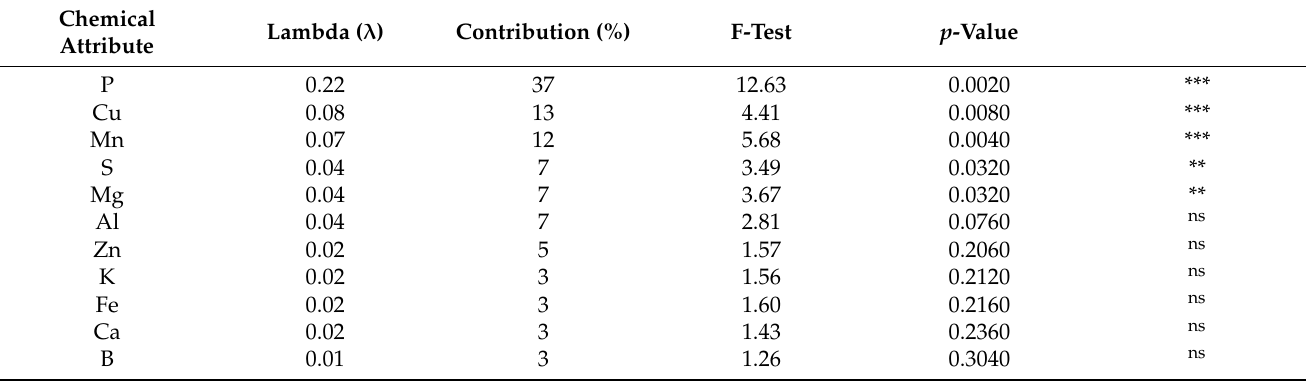
Summary of conditional effects between plant nutrients based on Monte Carlo permutation